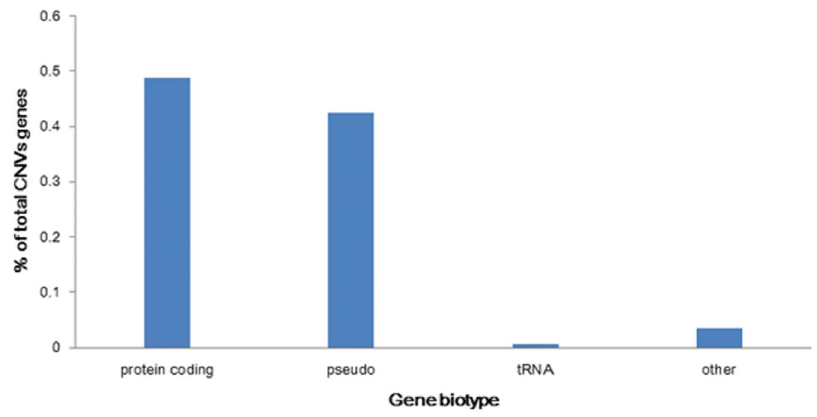
Figure 6. Percentage of gene biotypes affected by CNVs.